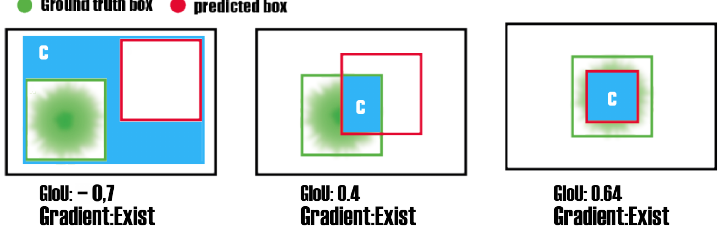
Figure 13. Various GIoU situations with values in each and an indicator of gradient presence in each case based on ’C’, which represents the Box Displacement between GT and